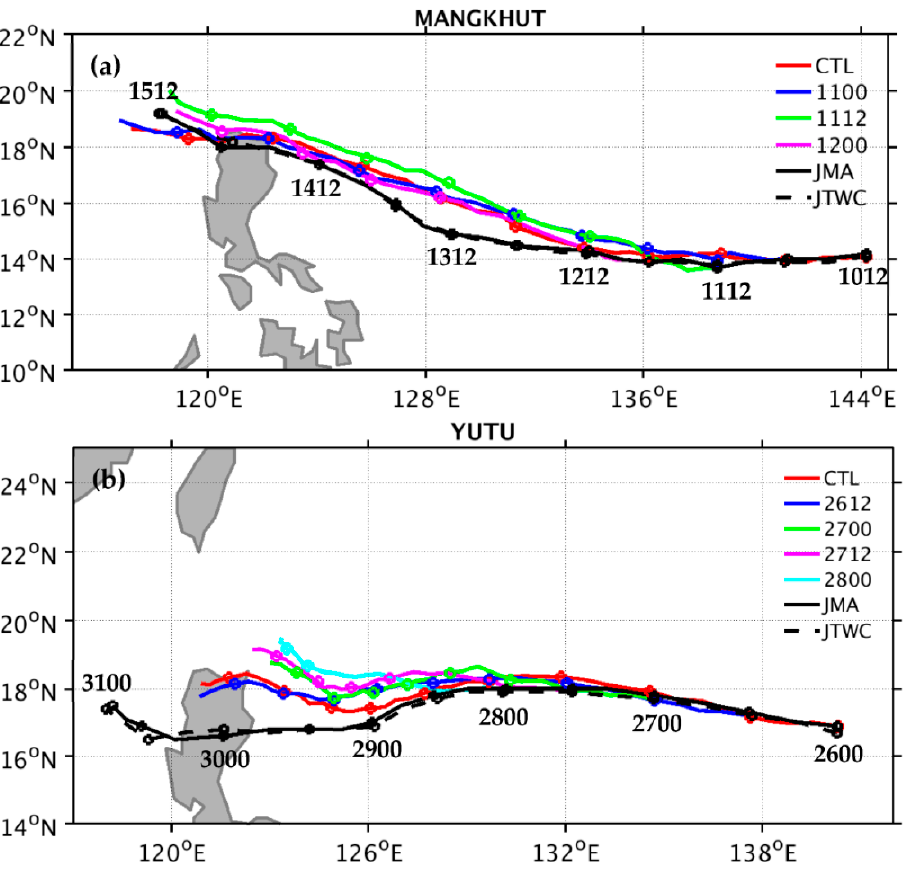
Figure 7. ( a ) Simulated tracks for Mangkhut at 1200 UTC 10 September (CTL, red), 0000 UTC 11 September (1100, blue), 1200 UTC 11 September (1112, green), and 0000 UTC 12 on September (1200, magenta), as well as the best track of the JMA (solid black) and the JTWC (dashed black). ( b ) Simulated tracks for Yutu at 0000 UTC 26 October (CTL, red), 1200 UTC 26 October (2612, blue), 0000 UTC 27 October (2700, green), 1200 UTC 27 October (2712, magenta), and 0000 UTC 28 October (2800, cyan), as well as the best track of the JMA (solid black) and the JTWC (dashed black). Circles mark typhoon centers every 12 h.